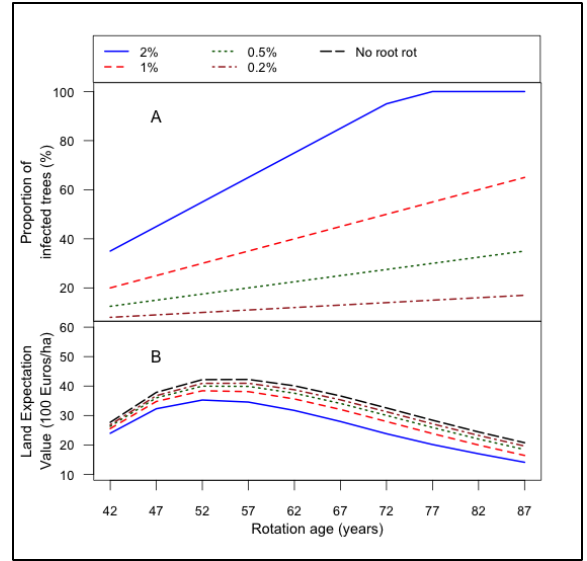
Figure 1. Changes in proportions of infected trees at final felling ( A ), and land expectation values ( B ), with stand age and indicated annual increases in root rot infection rates in the Norway spruce stand in southern Sweden.